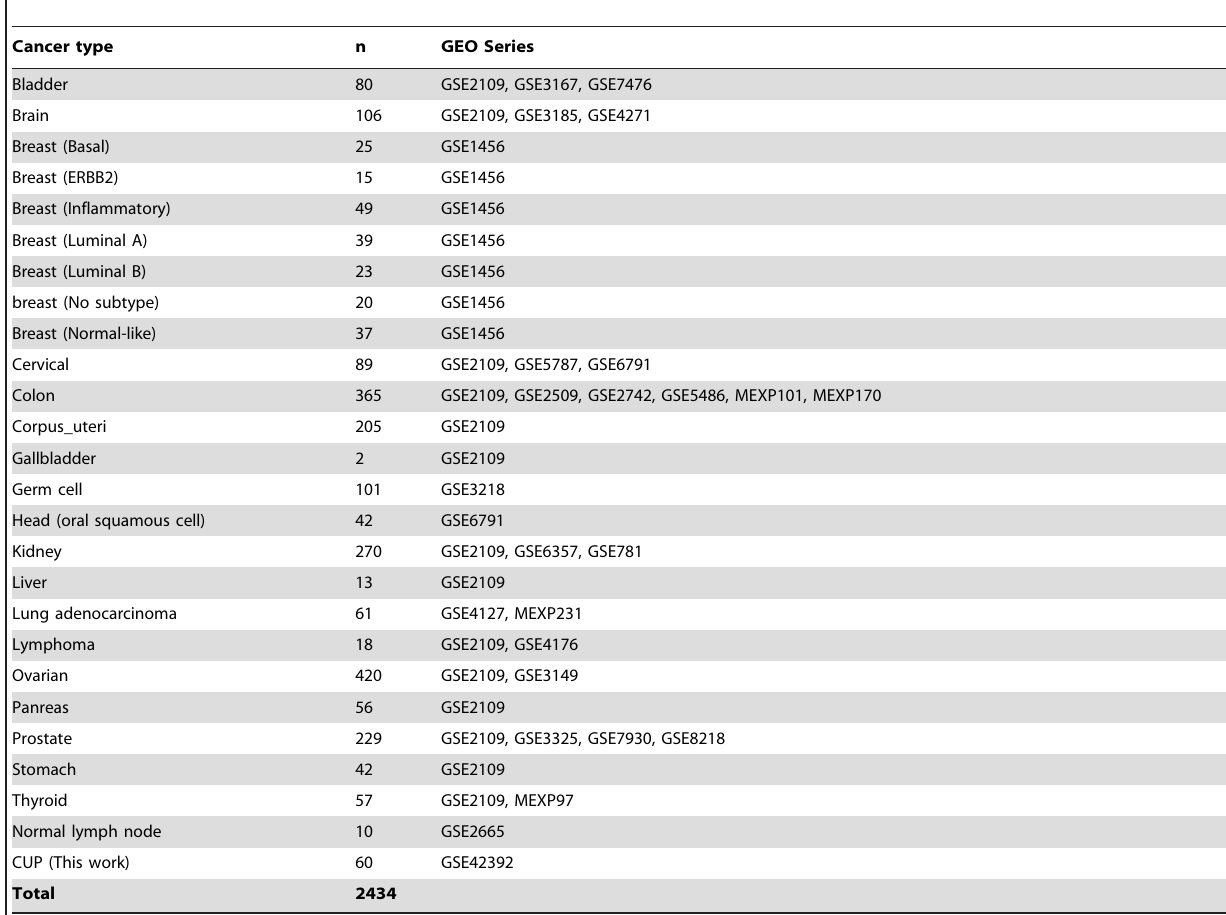
Table 1. Number of cases for each cancer type and GEO series used for gene expression profiles.